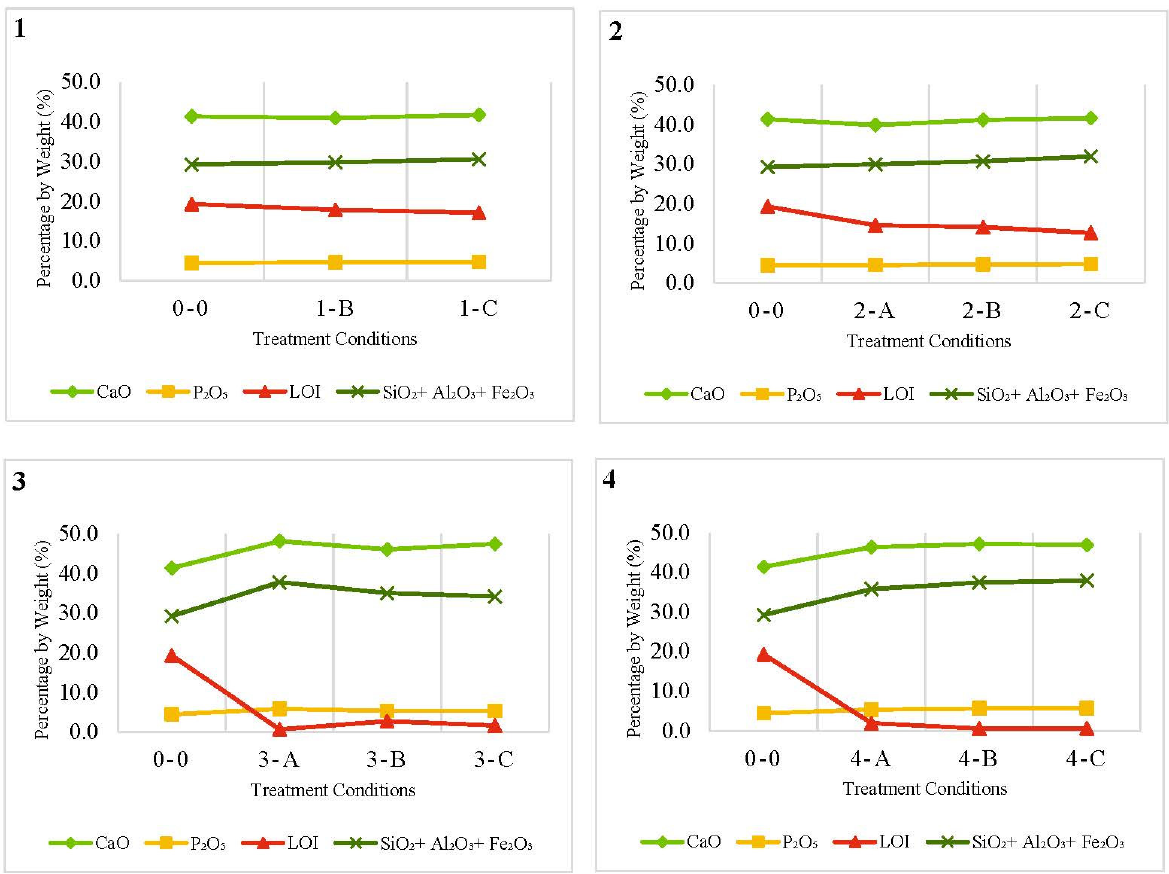
Figure 3. Comparison between (CaO, P 2 O 5 , LOI, and (SiO 2 + Al 2 O 3 + Fe 2 O 3 )) contents at different durations for specific calcination temperatures: ( 1 ) calcination at 550 °C for 4 h and 6 h, ( 2 ) calcination at 700 °C, ( 3 ) calcination at 850 °C and ( 4 ) calcination at 1000 °C for 2 h, 4 h and 6 h.